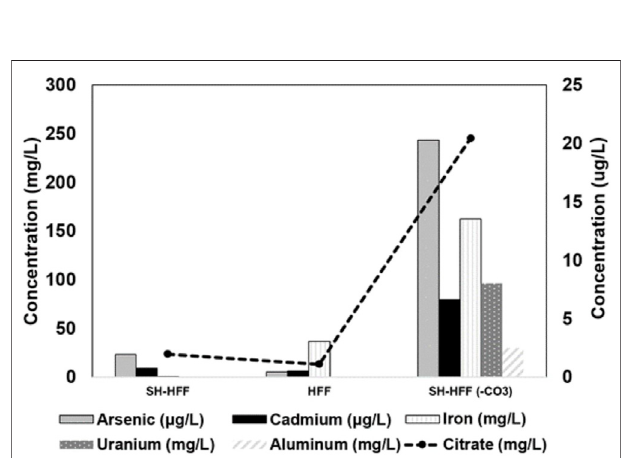
FIGURE 2 | Metals in solution released from reactions with shale. HFF serves as a control for contaminants in additives, reactor corrosion (Fe), and instrument